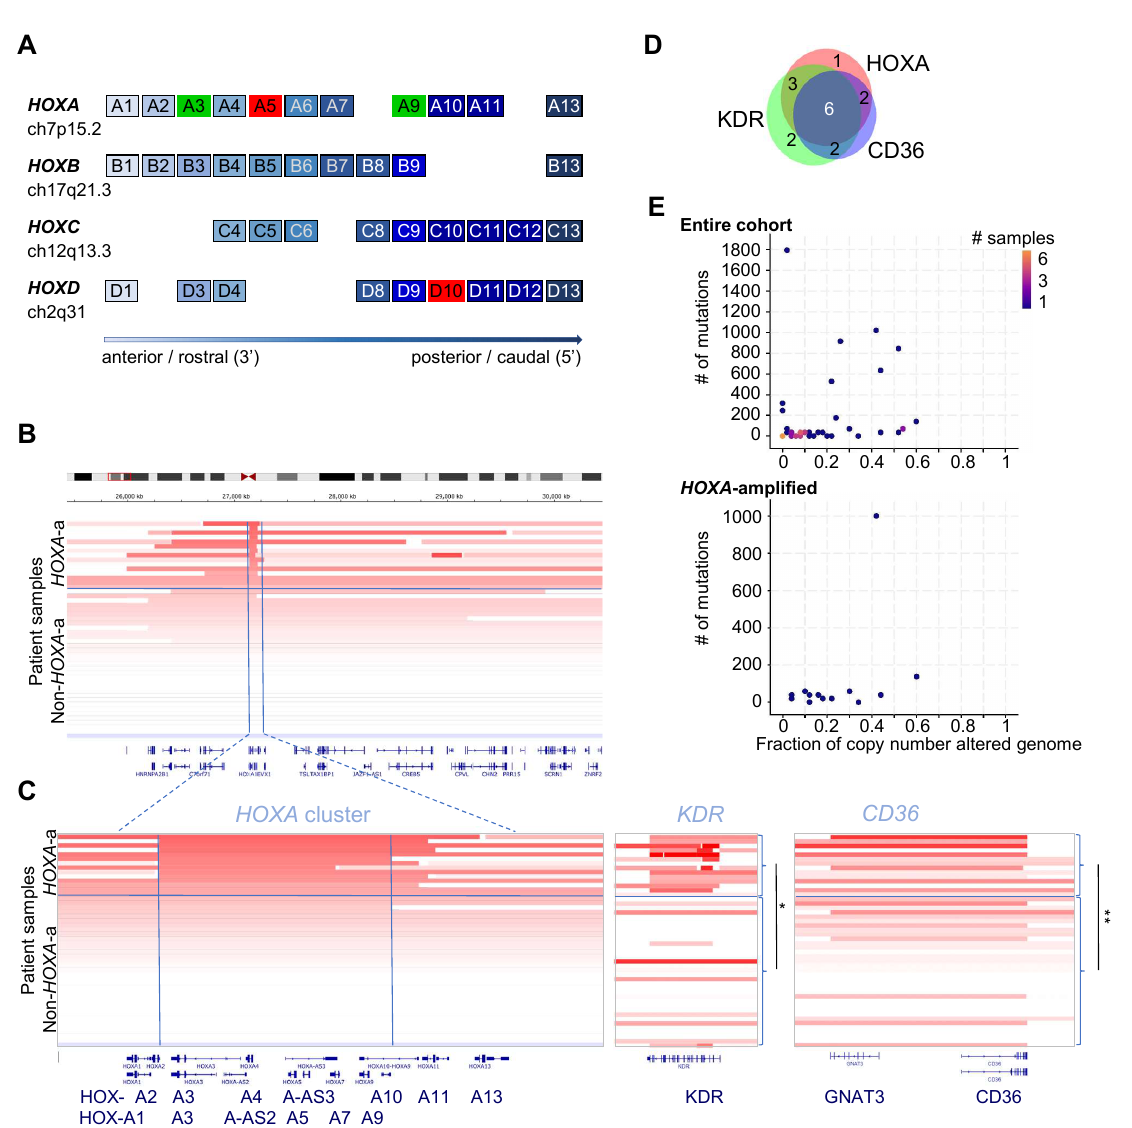
Figure 1. ( A ) Schematic of the human HOX clusters. Paralogs have the same number and coloring. The two key HOX -cluster genes that control EPC fate decisions and vasculogenesis, HOXA3 and HOXA9 , are marked in green. Anti-angiogenic HOXA5 and HOXD10 are marked in red. ( B ) HOXA - cluster amplifications in angiosarcoma. Out of 48 patient samples (12 out of 36 patients), 13 had amplifications in HOXA3. Most HOXA3 amplifications also encompassed additional 5 (cid:48) HOXA genes, including HOXA9 ( HOXA3 to HOXA9 marked by vertical lines in ( B ), p -value: 1.997 × 10 − 8 , p-adjust: 1.398 × 10 − 7 ), HOXA 11 ( p -value: 2.596515 × 10 − 7 , p-adjust: 1.817561 × 10 − 6 ) and HOXA13 ( p -value: 9.487666 × 10 − 5 , p-adjust: 6.641366 × 10 − 4 ). Copy numbers (CNs) were inferred using ReCapSeg, as described by Painter et al. [3]. Statistical significance was calculated using Fisher’s exact test (Bonferroni correction). Visualization was performed using the IVG in cBioPortal sorting on fold-change of the HOXA3 copy number. ( C ) HOXA -cluster, KDR and CD36 amplifications in angiosarcoma patient samples. Visualization of CN fold-change of the HOXA cluster, KDR and CD36 sorted on HOXA3-CN. * p < 1 × 10 − 5 , ** p = 3.6 × 10 − 4 , Mann–Whitney U test. ( D ) Venn diagram of HOXA -cluster, KDR and CD36 amplifications in angiosarcoma patients. ( E ) # of mutations (y-axis) and copy number alterations (x-axis) of the entire cohort (top panel) compared to HOXA -amplified angiosarcoma (bottom panel) using the visualization tools in cBioPortal. The difference was not statistically